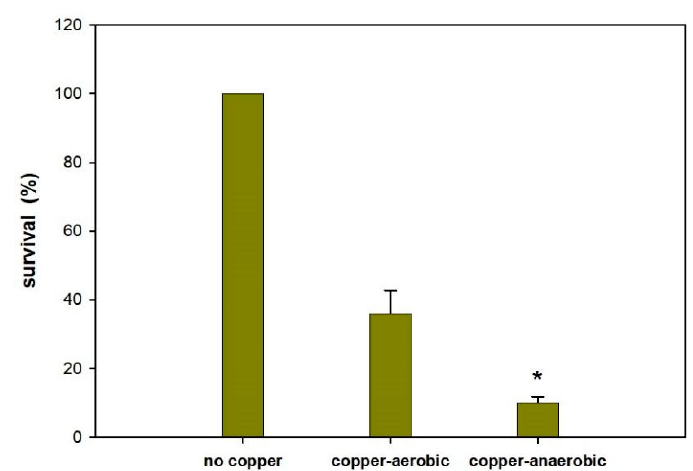
Figure 3. Exponentially growing cells with copper under aerobic and anaerobic conditions. Bacterial suspensions in 0.85% NaCl buffer supplemented or not with 32 mg/mL cupric sulfate for 60 min at 30 °C. A “no copper” control was used for each condition for comparison; i.e., for both anaerobic and aerobic conditions and is listed as 100%. The symbol * ( p < 0.05) indicates the significant difference compared to the control (“no copper”).